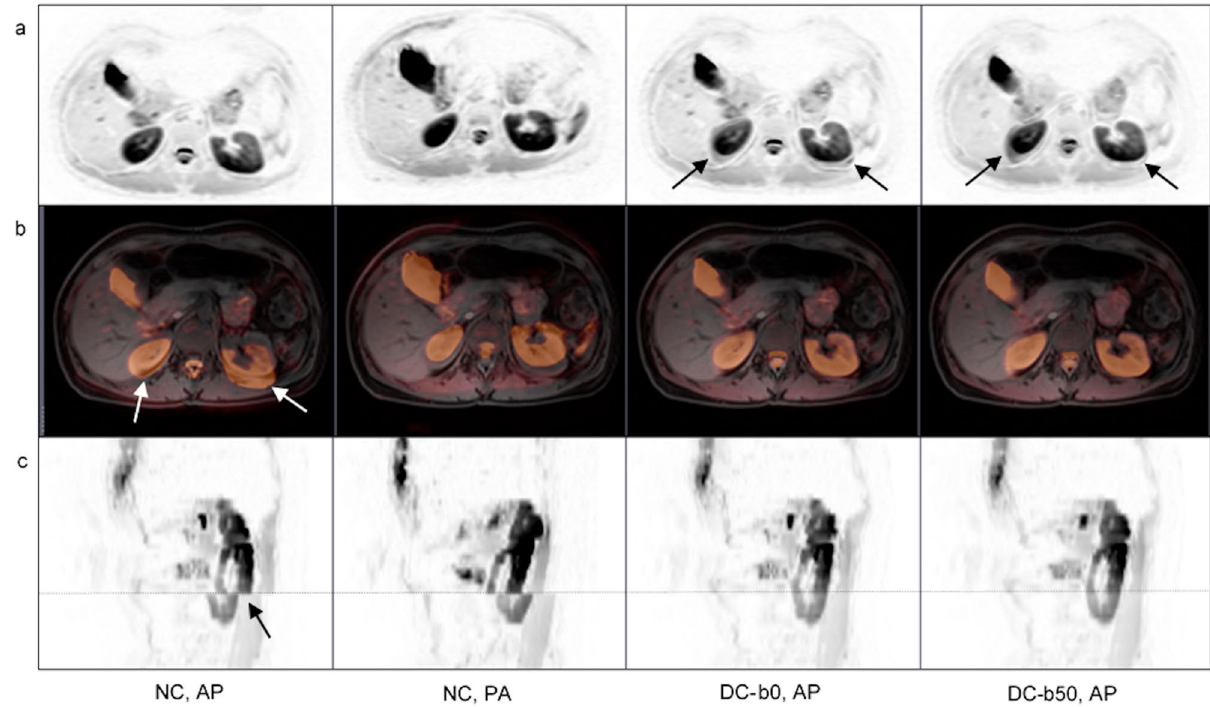
Figure 7. Typical registration artefact caused by the RPG method as observed at 3T. Axial b50 images ( a ) axial b50 images overlaid on corresponding structural images ( b ) and sagittal b50 images ( c ) are shown. In each column (left to right) the non-corrected (NC) anterior–posterior (AP), NC posterior-anterior (PA), b0-based distortion corrected (DC-b0) AP and b50-based distortion corrected (DC-b50) AP images are displayed. Axial b50 images in inverted grey scale show the kidney registration artefact as marked by arrows ( a ). Although artefacts are introduced, there is an improvement in the geometrical alignment. This is exemplified by zoomed axial b50 images in yellow color scale overlaid on corresponding structural images ( b ) and by sagittal b50 images in inverted grey scale ( c ). Misalignments in NC AP images are indicated with arrows in ( b ) and ( c ). For the sagittal images the station border is marked with a dashed line. The radiologists’ assessments of overall image quality gave a mean score of 1.0 and 1.7 for the DC-b0 and DC-b50 images,